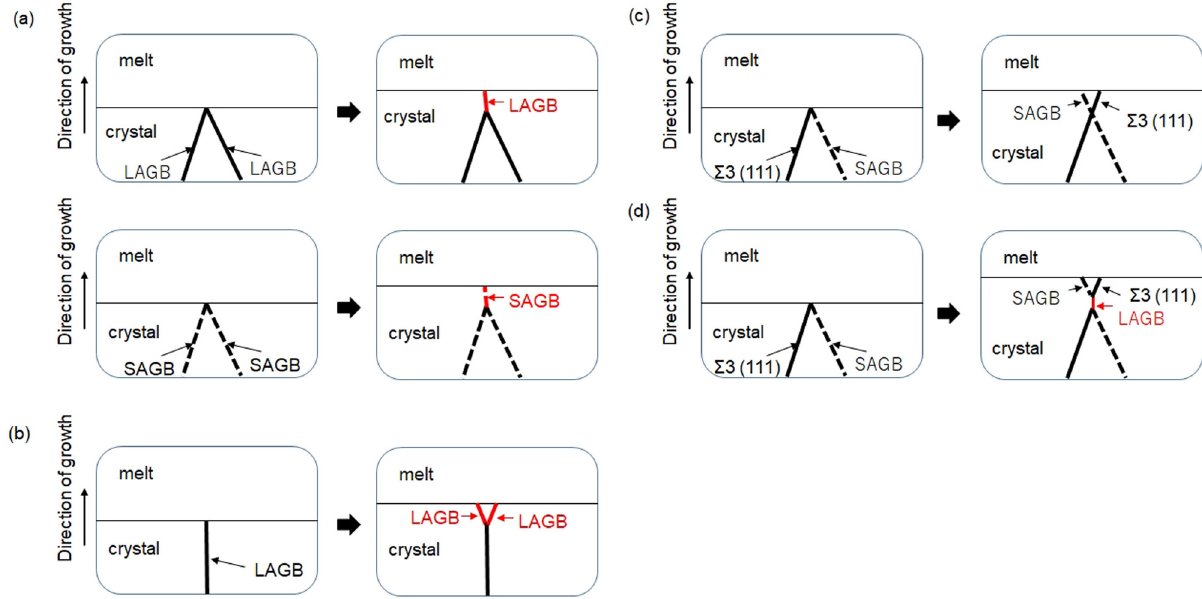
Figure 16: Summary of the observed interactions of grain boundaries at a crystal/melt interface: ( a ) two - grain boundaries produce a single grain boundary, ( b ) one grain boundary splits into two grain boundaries, ( c ) two grain boundaries penetrate each other, and ( d ) one grain boundary is formed after the impingement of two grain boundaries, but it splits into two grain boundaries